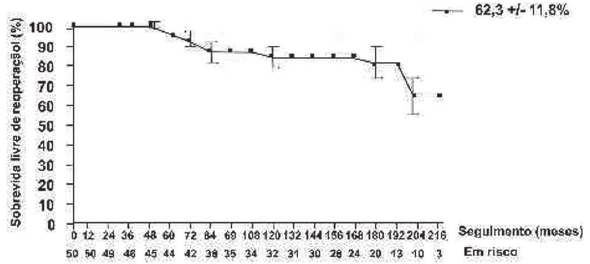
Fig. 2 - Sobrevida actuarial livre de reoperação